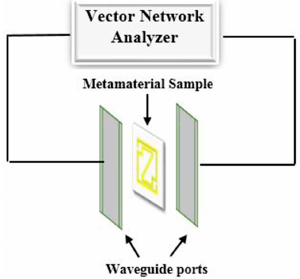
Figure 3. Experimental setup for measuring the S-parameters.